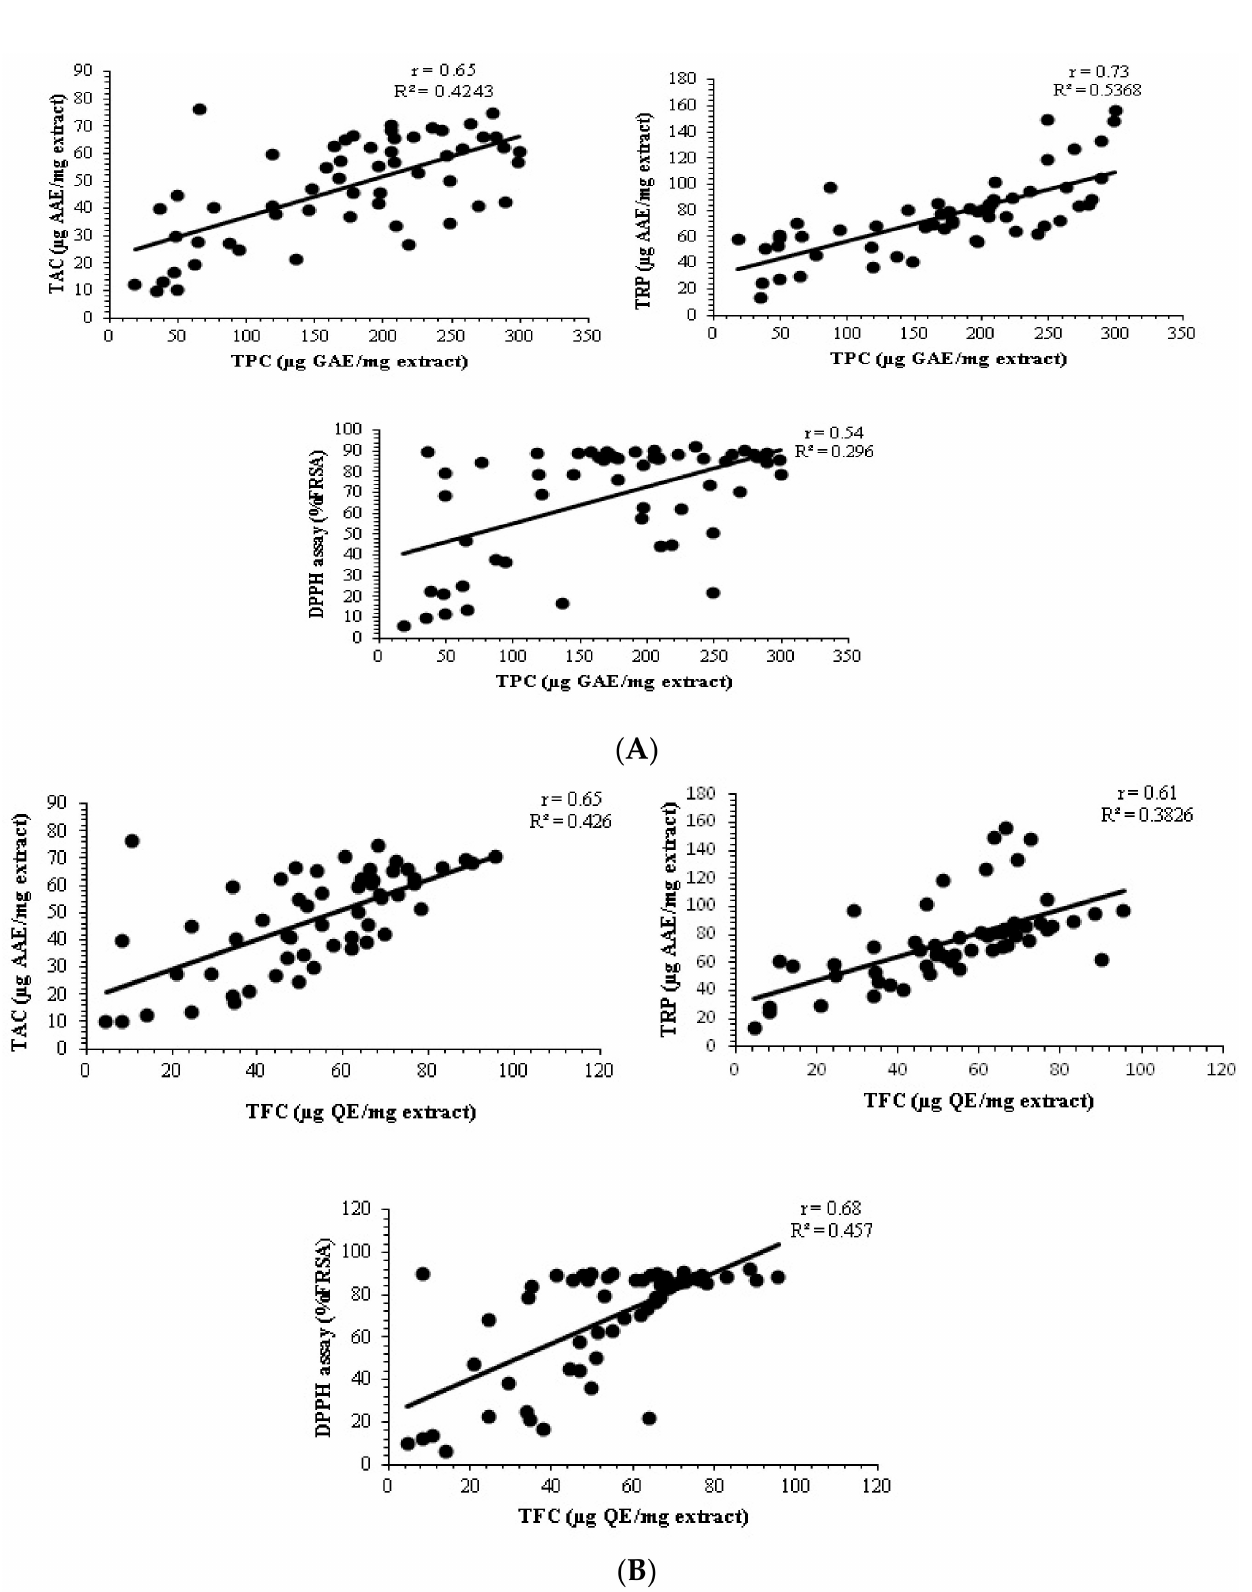
Figure 4. ( A ). Correlation between total phenolic content and different antioxidant assays. ( B ) . Correlation between total flavonoid content and different antioxidant